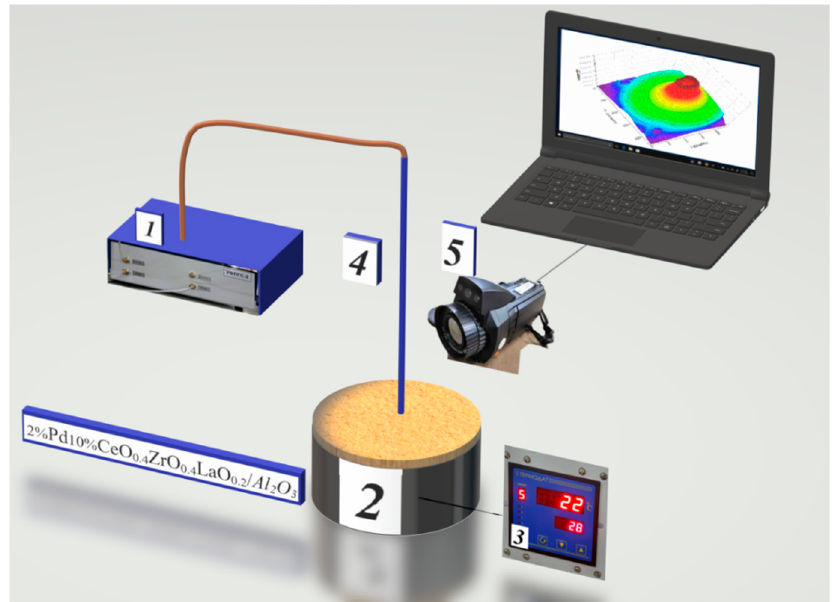
Figure 1. The scheme of experiment with the catalytic surface. 1—gas flow controller; 2—catalytic surface; 3—heater with temperature controller meter; 4—fuel supply pipe; 5—thermal imaging camera.